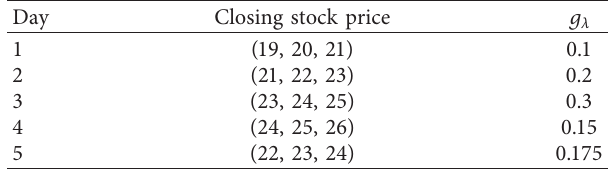
Table 1: Closing stock prices over 5 days.